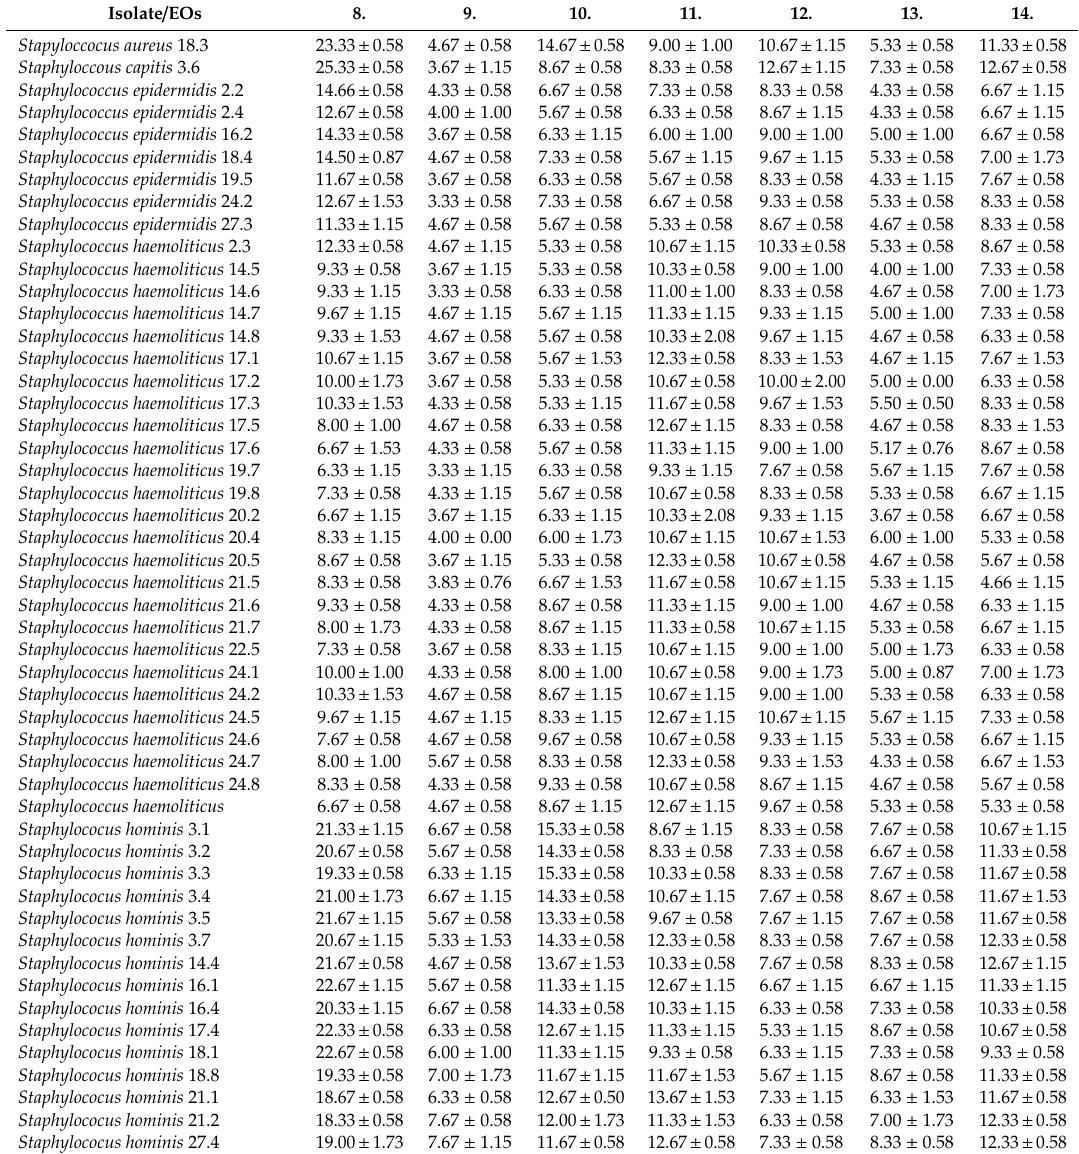
Table 4. Antimicrobial activity of EOs with disc di ff usion method in mm.